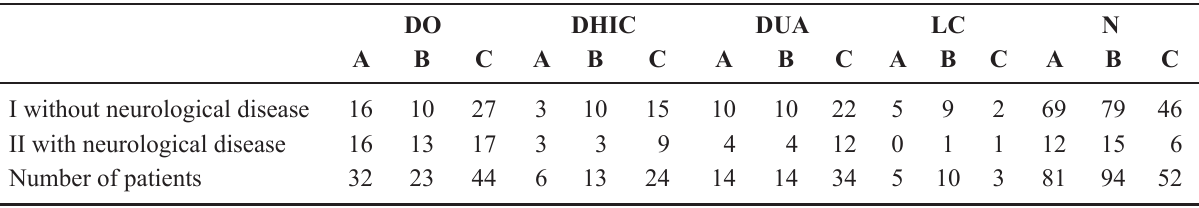
Table 5 – Detrusor behavior vs. age and neurological status. DO = detrusor overactivity; DHIC = detrusor hyperactivity with impaired contractility; DUA = detrusor underactivity; LC = low bladder compliance; N =